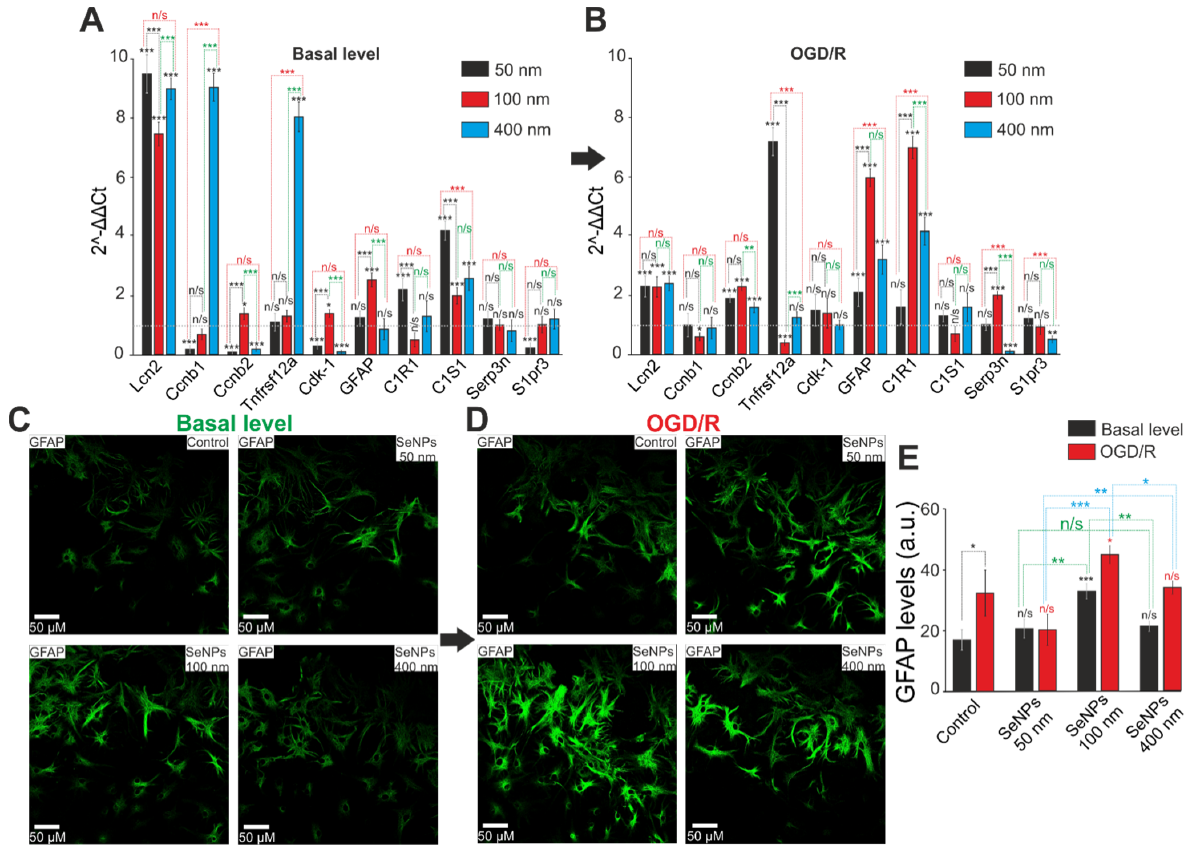
Figure 11. The effect of 24-h incubation of mouse cortical cells with 3 µ g/mL of different-sized SeNPs on the activation of basal and OGD/R-induced reactive astrogliosis. ( A , B )—SeNPs ( A ) and OGD/R-induced ( B ) changes in the expression of genes encoding proteins marker of astrocyte reactivity. Dashed line for panels ( A )—level of gene expression in controls (without treatments). Dashed line for panel ( B )—level of gene expression in OGD/R cortical cultures. ( C , D )—Immunocytochemical staining of cortical cell culture with astrocytic marker; antibodies against glial fibrillary acidic protein (GFAP) after 24-h incubation with 3 µ g/mL of different-sized SeNPs without OGD/R ( C ) and 24 h after OGD/R ( D ). ( E )—Intensity levels of GFAP were determined by confocal imaging. We analyzed individual cells that had fluorescence of secondary antibodies. The quantative data reflecting the level of GFAP expression are presented as fluorescence intensity values in summary bar charts (mean ± SEM). The values were averaged by 150–200 cells for each column. The results obtained after immunostaining agree with the data of fluorescence presented in panels ( C , D ). Each value is the mean ± SE ( n ≥ 3, p < 0.05). Statistical significance was assessed using paired t -test. Black asterisks represent comparison of baseline expression levels after incubation with different-sized nanoparticles versus control. Red asterisks represent comparison of expression level after incubation with different- sized SeNPs versus OGD/R-induced levels; n/s—data not significant ( p > 0.05), * p < 0.05, ** p < 0.01, *** p <